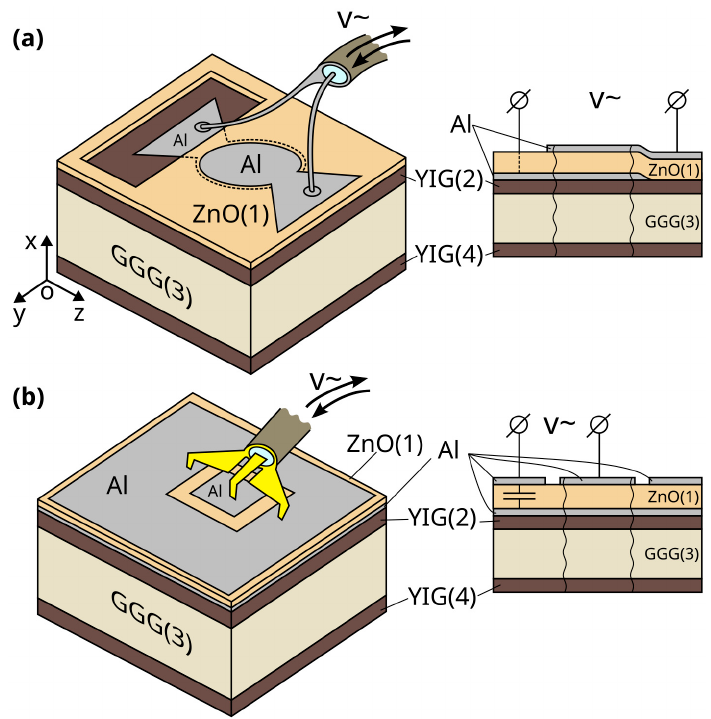
Figure 1. Schemes of the HBAR consisting of YIG(2)-GGG(3)-YIG(4) and piezoelectric transducers based on ZnO films (1) with different shapes of Al electrodes and different types of contact with the bottom electrode ( a ) with ohmic contact ( b ) with capacitive contact.